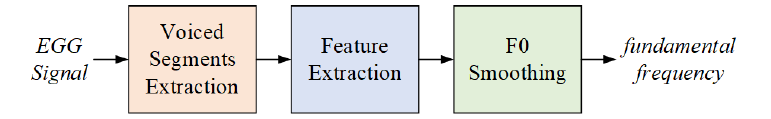
Figure 3. The structure of the EGG feature exaction